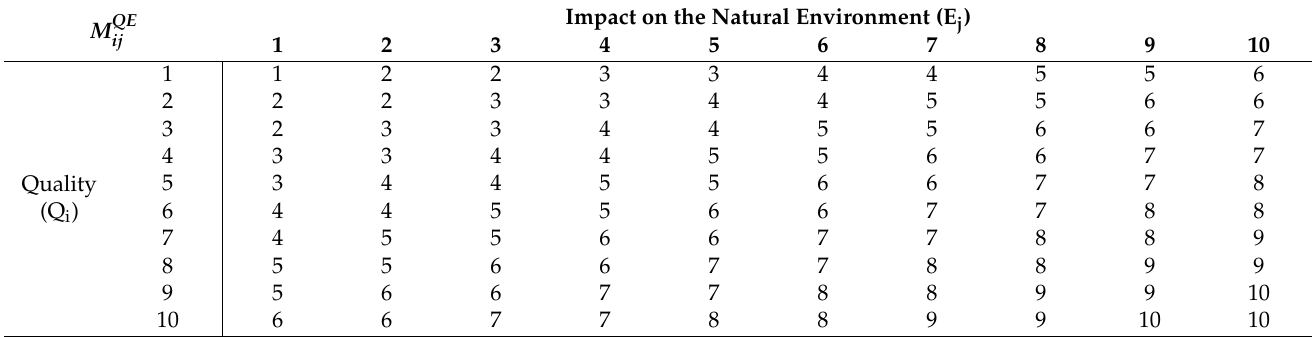
Table 8. Matrix to select qualitative-environmental indicator (QE) in ordinal